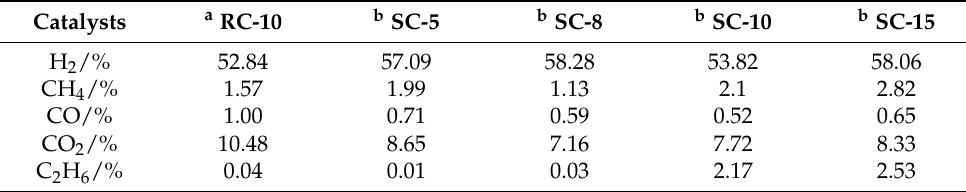
Table 3. Hydrodeoxygenation reaction exit gas components analysis by GC.